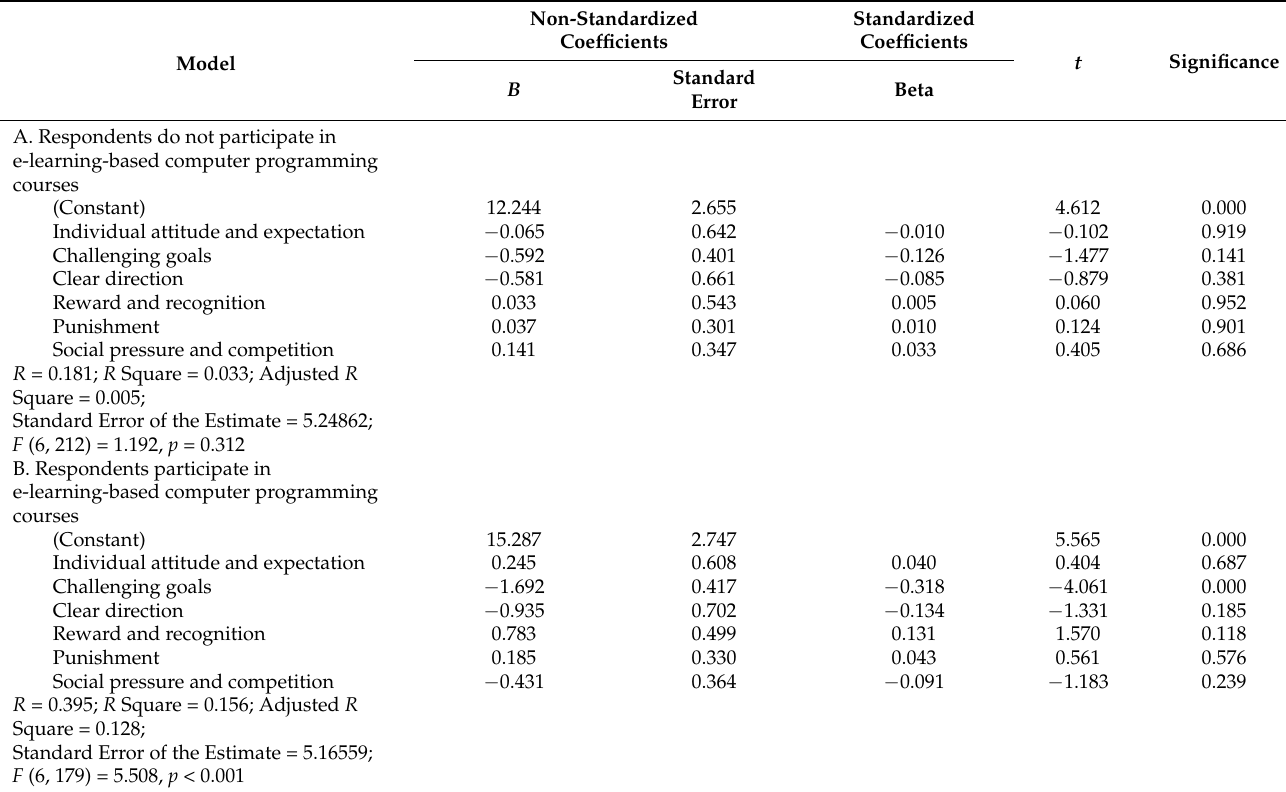
Table 11. Multiple regression models in which the dependent variable is anxiety and the predictors are learning motivat- ing factors.